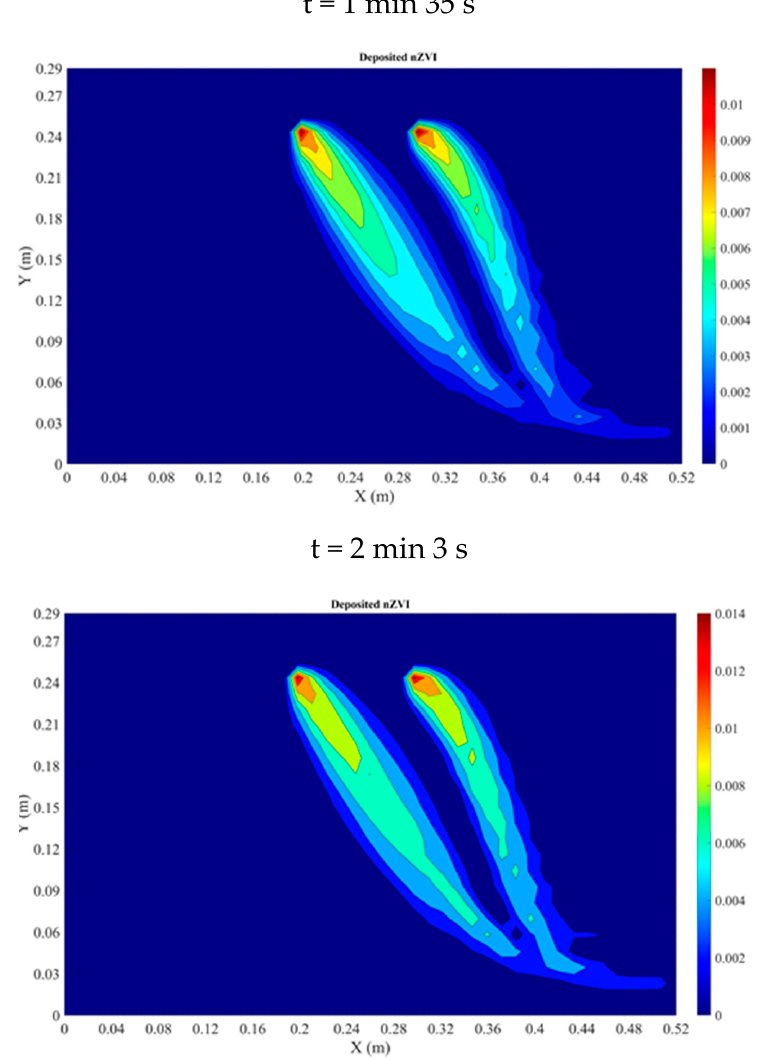
Figure 3. Results of numerical model simulations (during the injection time) .